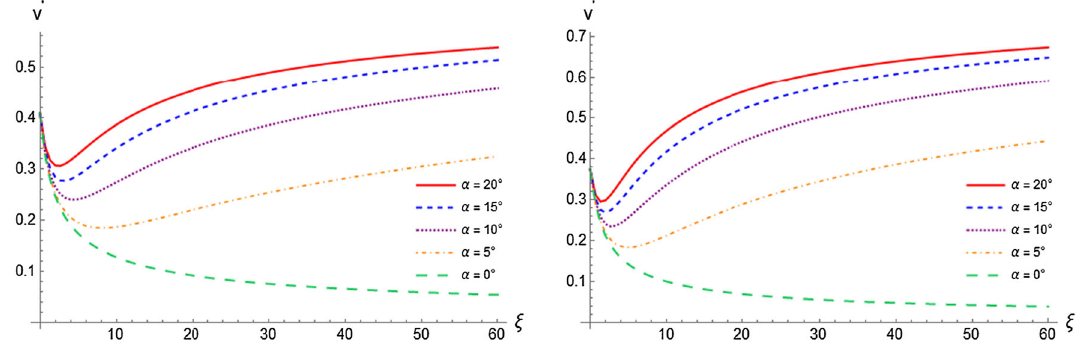
Fig. 7 Plots of the absolute value of downstream velocity | v (cid:2) (ξ | α) | as a function of the anisotropy parameter ξ for α = 20 ◦ (solid), α = 15 ◦ (dashed), α = 10 ◦ (dotted), α = 5 ◦ (dash-dotted) and α = 0 (long dash) for σ = 5 (left) and σ = 10